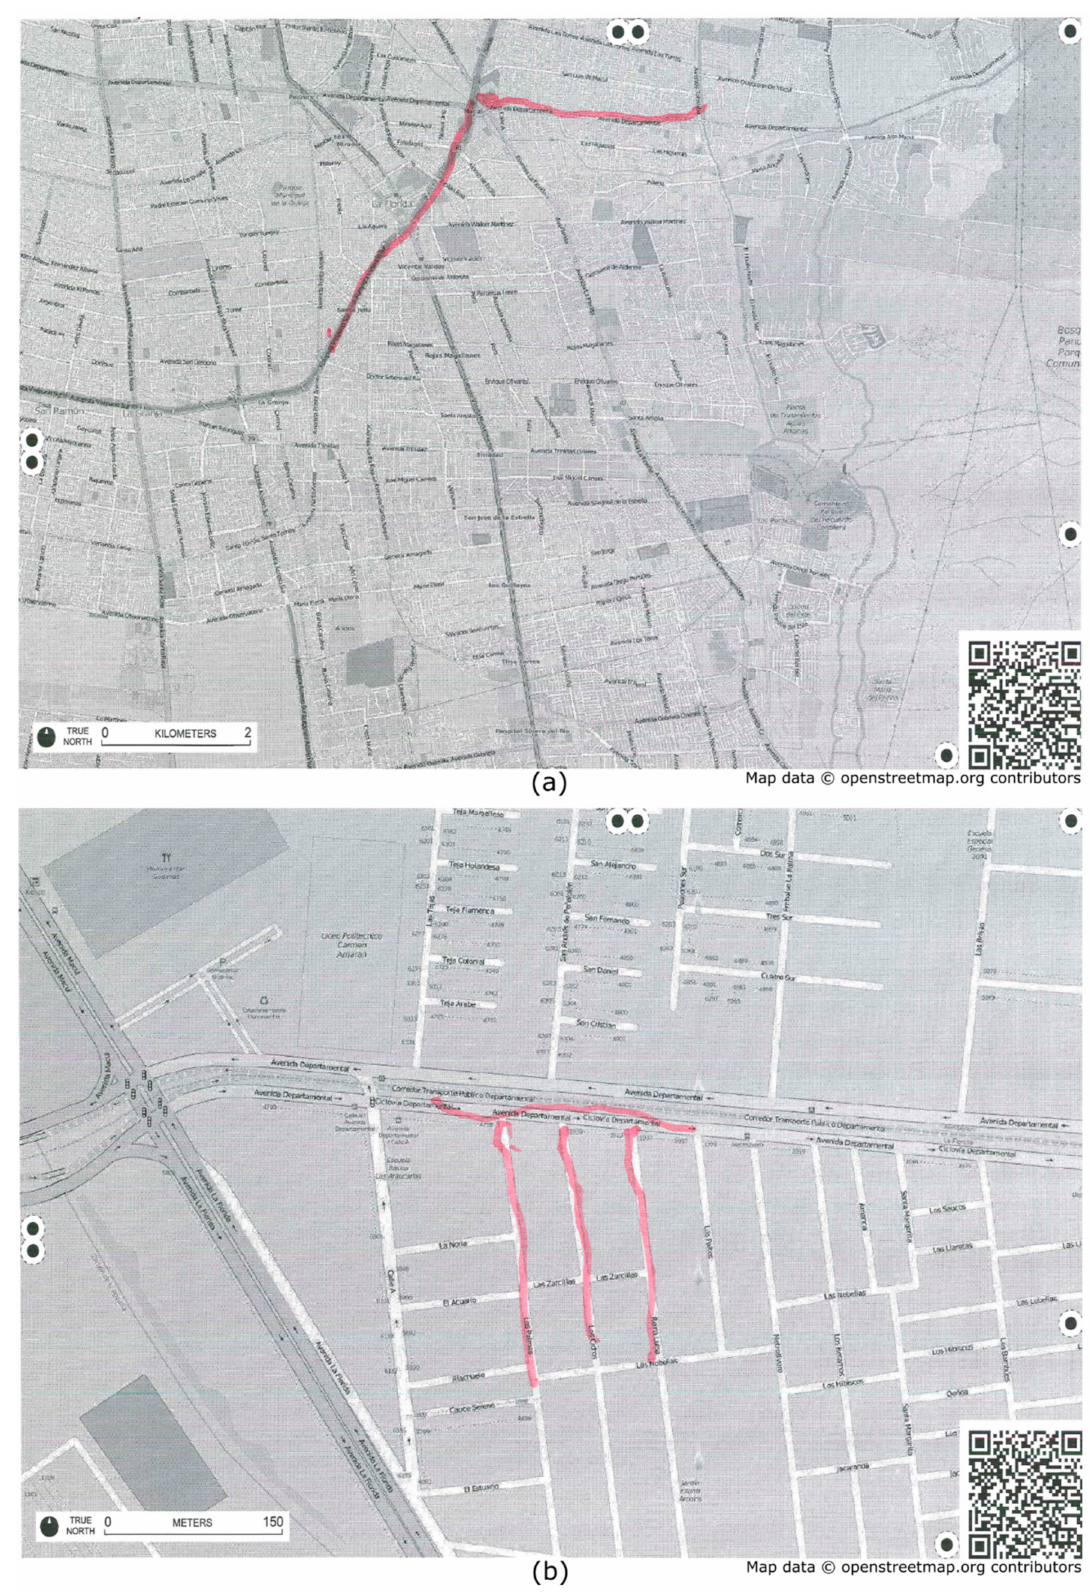
Figure 2. Sketch maps with a single participant‘s risk perception marked in red. ( a ) Overview base layer of La Florida, Santiago de Chile; ( b ) detailed view of the study area. QR-Code and black dots allow fast automatic georeferencing of the sketch map. Based on OSM Field Papers